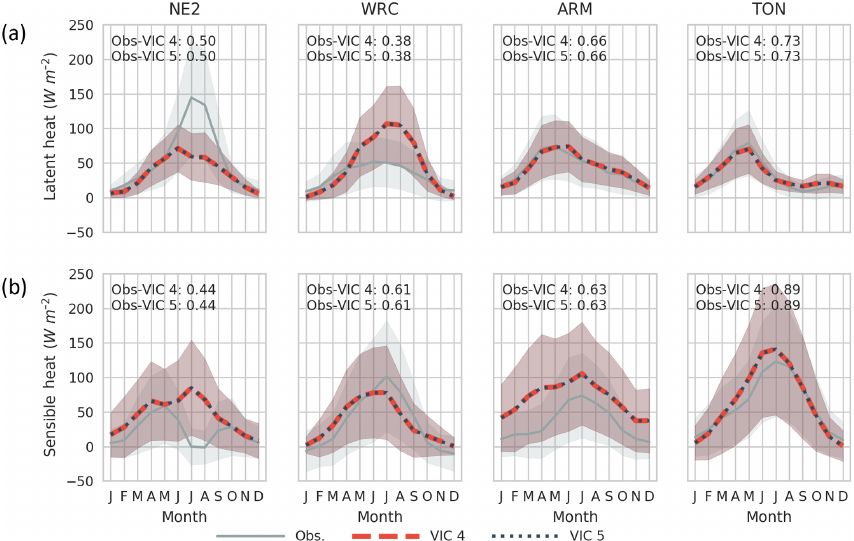
Figure 3. Example summary output from the VIC-5 science testing package comparing the annual cycle of latent heat (a) and sensible heat (b) for four sample locations for VIC-4 (red) and VIC-5 (blue) to FLUXNET observations (gray). The shaded range represents the interannual variability ( ± 0 . 5 SD). The r 2 statistic shown in the upper left corner is calculated using the hourly time series from the observations and model output from VIC-4 and VIC-5. The r 2 statistic comparing VIC-4 and VIC-5 is 1.00 for all sites and is not shown in this